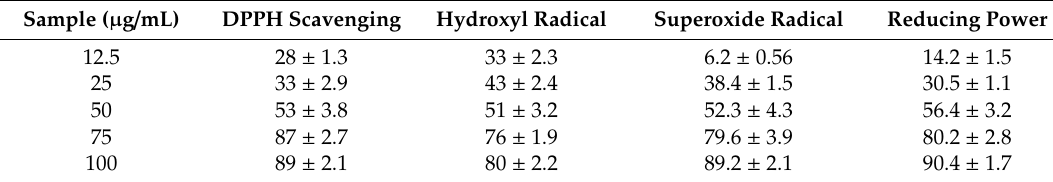
Table 6. Antioxidant activity of cell-free extract isolated from L. reuteri LR12.